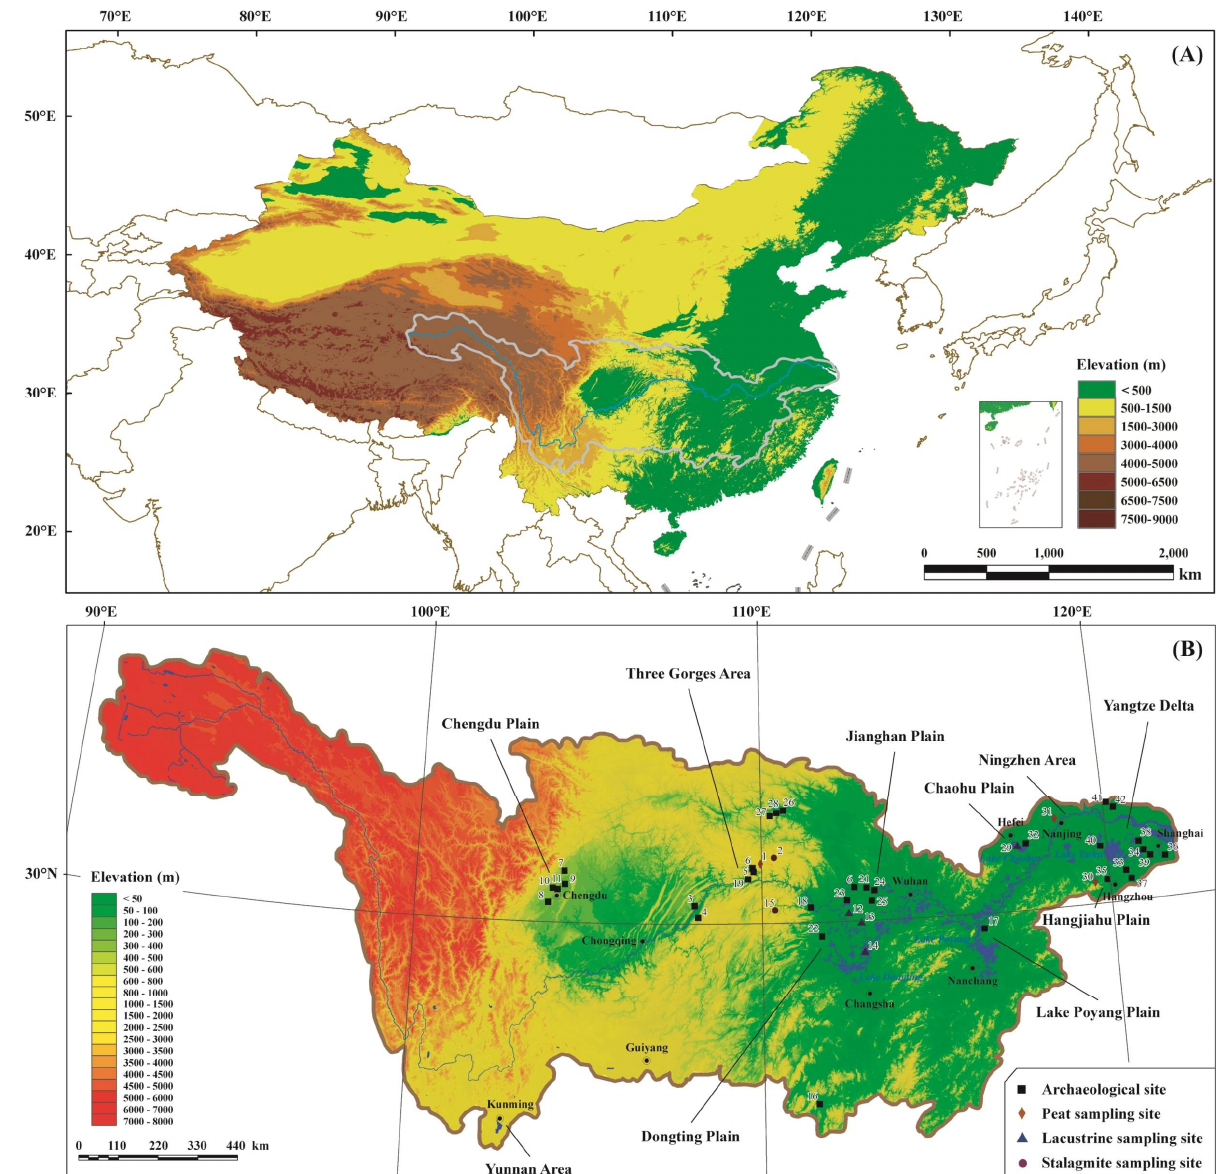
Figure 1. ( A ) Location of the Yangtze River Valley in China, the topographic map is based on a 30 m Digital Elevation Model (DEM). ( B ) Geomorphic features and main Neolithic cultural areas of the Yangtze River Valley, showing the locations of sites mentioned in the text and the distribution of large freshwater lakes; 1: Dajiuhu; 2: Shanbao Cave; 3: Zhongba; 4: Yuxi; 5: Zhangjiawan; 6: Shuangyantang; 7: Guiyuanqiao; 8: Baodun; 9: Sanxingdui; 10: Jinsha; 11: Shi-erqiao; 12: JZ-2010 section; 13: Zhoulao core; 14: Lake Dongting core; 15: Heshang Cave; 16: Yuchanyan; 17: Xianrendong; 18: Chengbeixi; 19: Daxi; 20: Qujialing; 21: Shijiahe; 22: Chengtoushan; 23: Zhongqiao; 24: Tanjialing; 25: Sanfangwan; 26: Liaowadian; 27: Lijiazui; 28: Tuojiazhou; 29: Lake Chaohu core; 30: Qianmutian; 31: Linfengqiao; 32: Tangzui; 33: Majiabang; 34: Songze; 35: Liangzhu; 36: Maqiao; 37: Caoxieshan; 38: Chuodun; 39: Guangfulin; 40: Luotuodun; 41: Qingdun; 42: